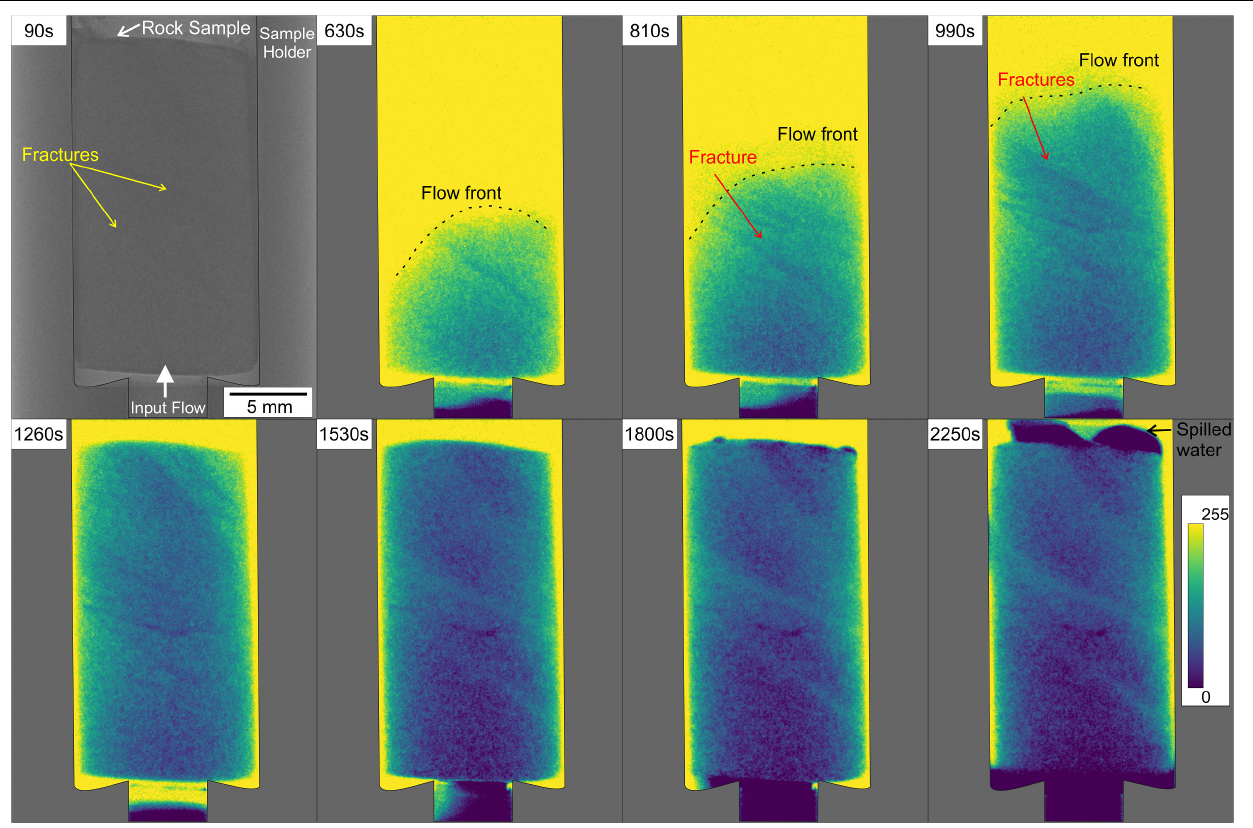
FIGURE 4 | Time lapsed neutron radiographs showing the flow of deionized water for the sample corresponding to the Orfento grainstone containing fractures. The image at 90 s (in original gray scale color) corresponds to a stage where the water still not entered into the rock sample. The rest of the images (in false color) correspond to input fluid into the sample obtained by subtracting the original dry condition (90 s) to radiograph to the n-time radiograph. The stages from 630 to 1260 s show the fluid filling the rock sample. The stages from 1530 to 2250 s show an increment in the fluid saturation until the water is spilled due to oversaturation.